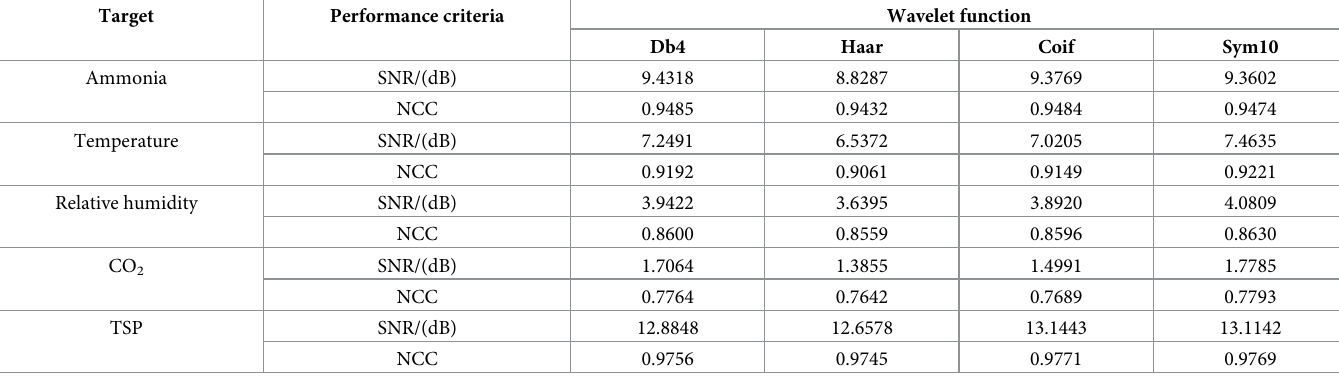
Table 2. Denoised performance of five